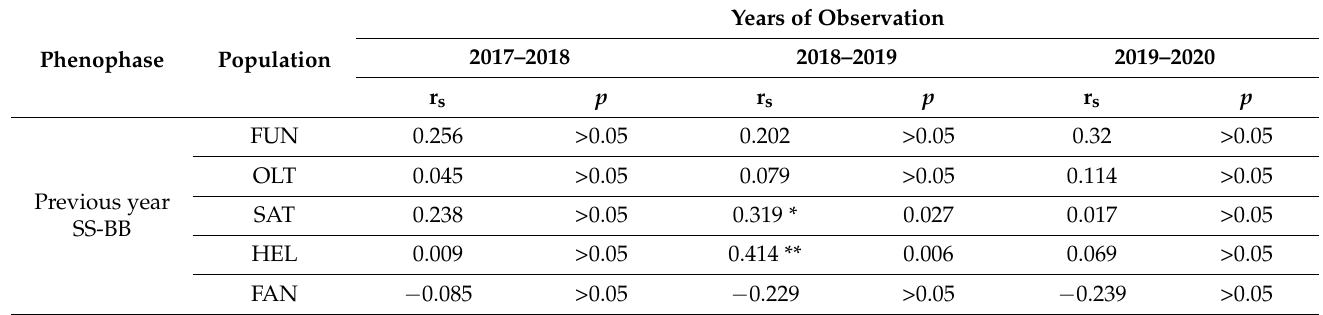
Table 10. Correlations between budburst and previous year senescence based on the recorded phenological